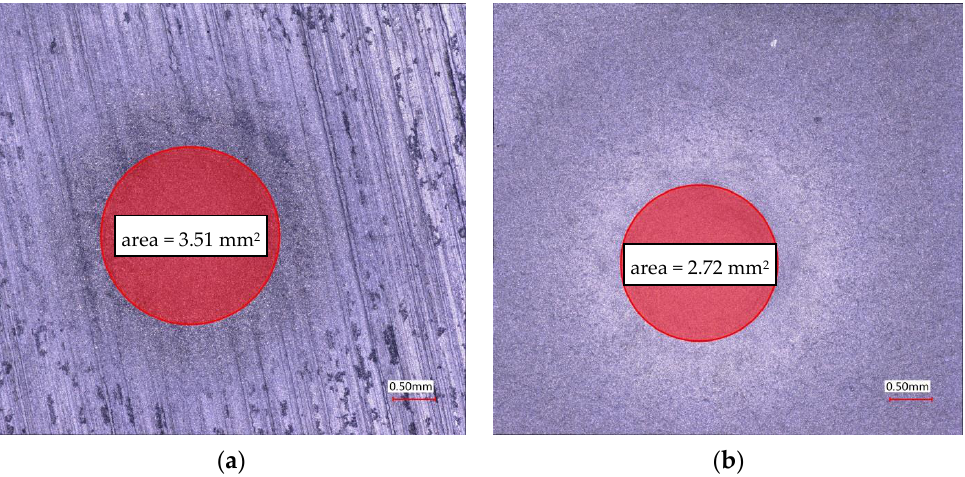
Figure 8. The comparison of the erosion craters of: ( a ) magnesium substrate and ( b ) composite coating.